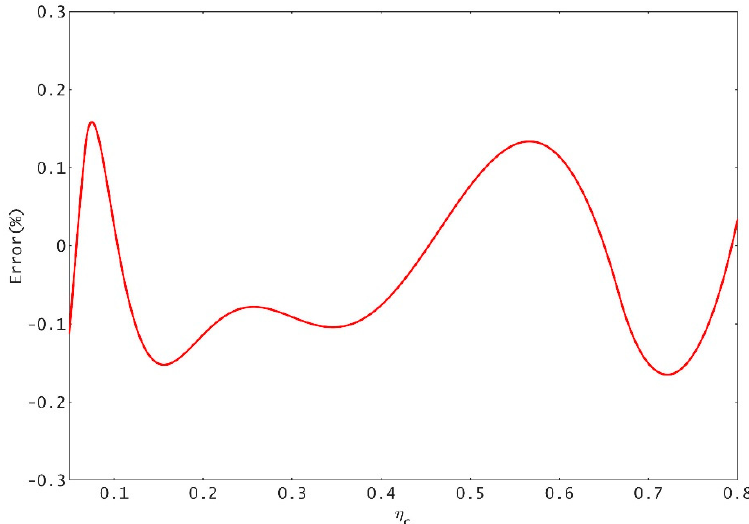
Figure 9. Error analysis of the critical depth formula for egg-shaped sections.